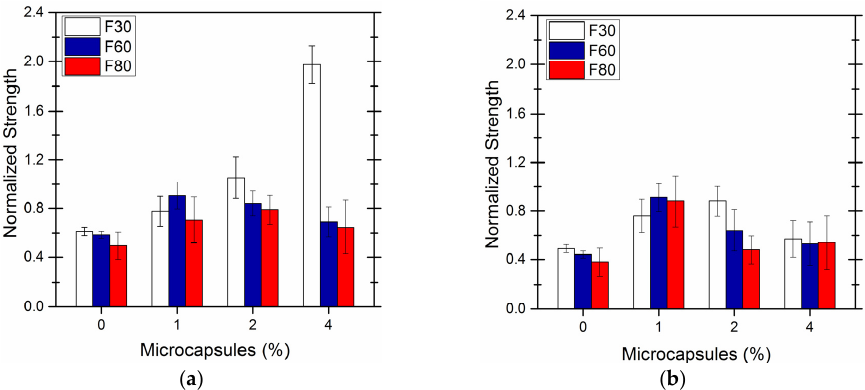
Figure 14. Flexural strength restoration rate of specimen with different content of